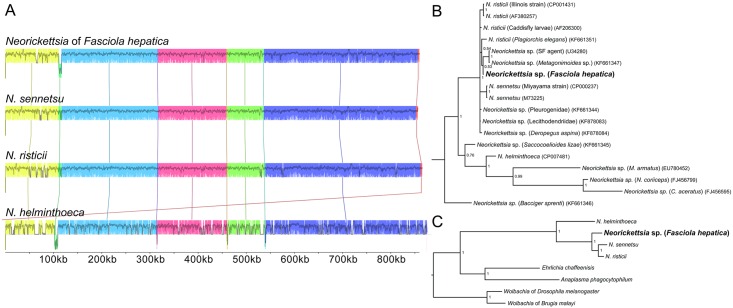
Phylogenetic affinities of the Neorickettsia symbiont of Fasciola hepatica.(A) The genomes of the four fully sequenced Neorickettsia species were aligned. Syntenic blocks are colored. The genome of the Neorickettsia of Fasciola hepatica (PRJNA295290) shares almost complete synteny with the genomes of Neorickettsia risticii (PRJNA19099) and Neorickettsia sennetsu (PRJNA357), with the exception of a small inversion that is also present in Neorickettsia helminthoeca (PRJNA187358). (B) Bayesian inference phylogenetic analysis based on available 16S ribosomal RNA sequences of Neorickettsia species, retrieved from [15]. While the resolution of the sub-clade consisting of Neorickettsia risticii and Neorickettsia
sennetsu is sub-optimal, the tree indicates that the Neorickettsia of Fasciola hepatica (nFh) may be most closely related to a strain that occurs in Metagonimoides species and an agent of Sennetsu fever. (C) A Bayesian inference phylogenetic tree based on the protein sequences of 473 single-copy, orthologous protein families conserved in the represented species clearly indicates that nFh is more closely related to N. risticii and N. sennetsu than N. helminthoeca or other species of the family Anaplasmataceae. NCBI GenBank accession numbers are indicated. Trematode hosts or other defining features are indicated for uncharacterized species.